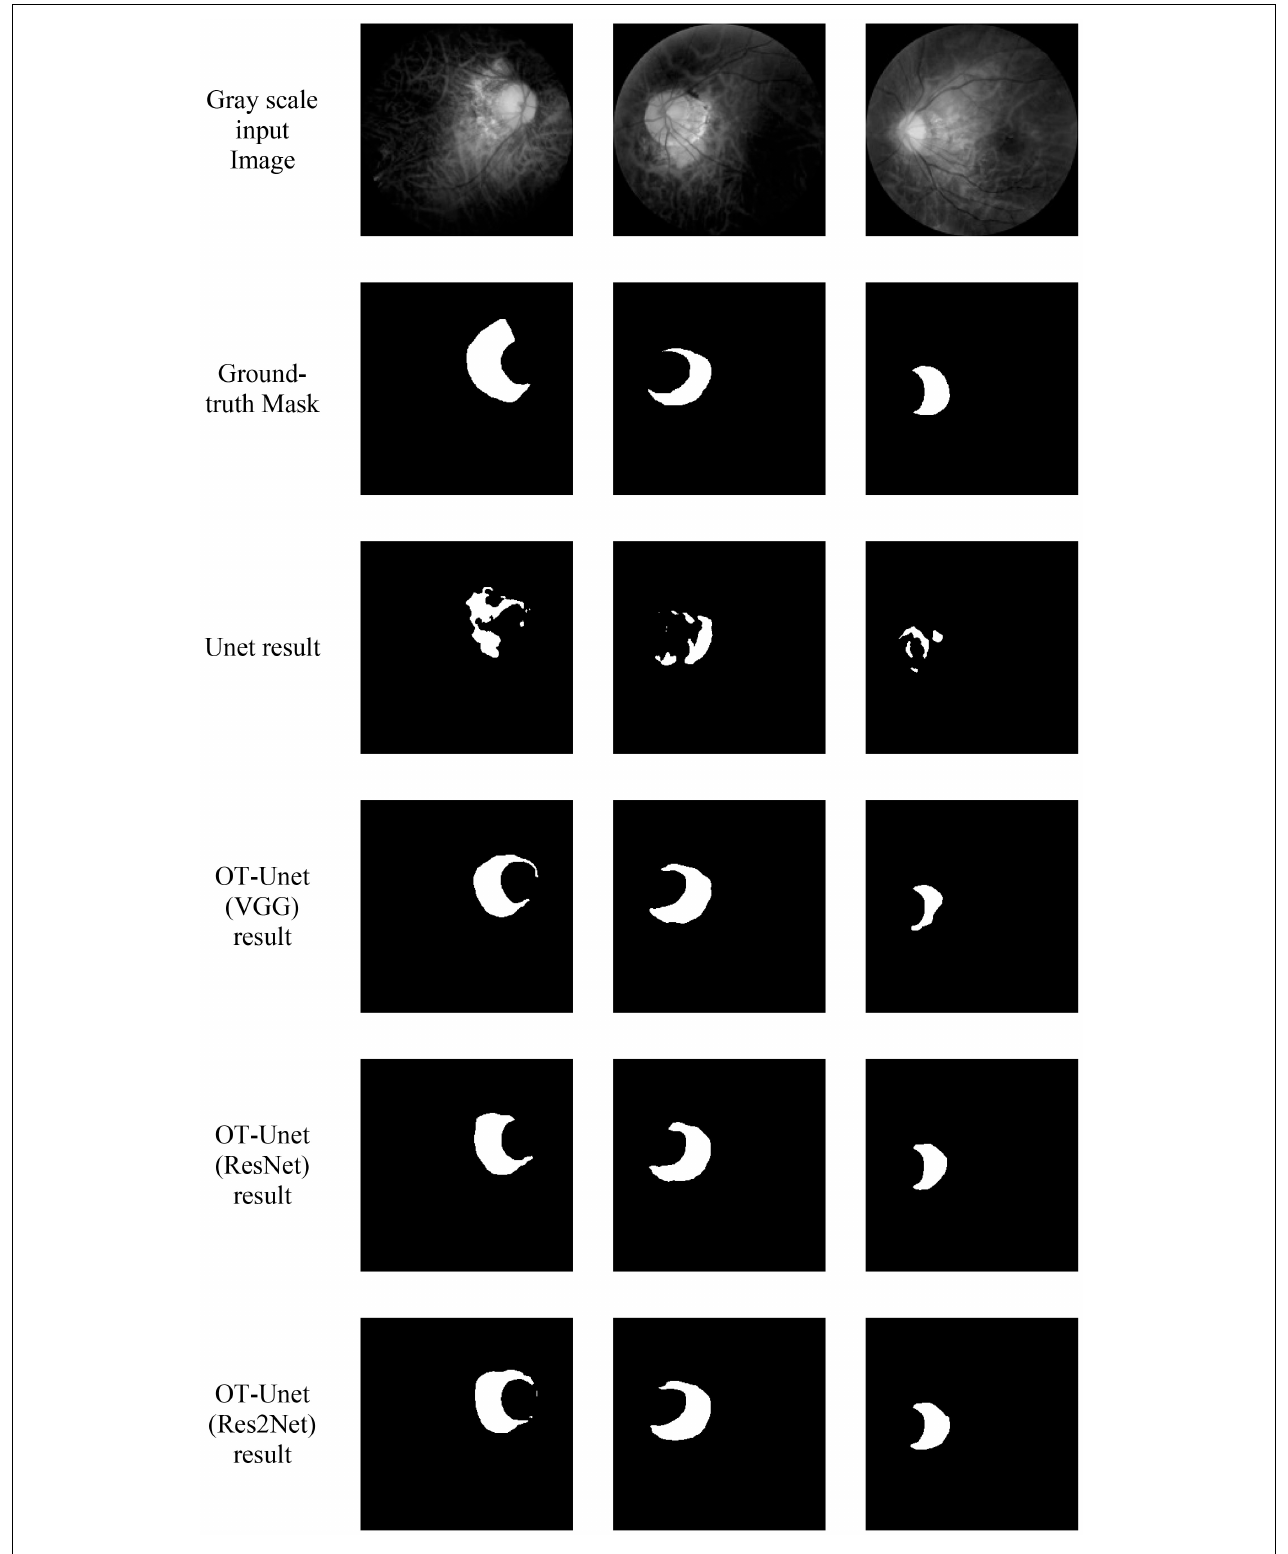
FIGURE 7 | Visualized results of the segmentation of parapapillary atrophy in high myopia: It shows the Gray scale input Image, the Ground-truth Mask, and the segmentation results of Unet, OT-Unet (VGG), OT-Unet (ResNet), and OT-Unet (Res2Net).